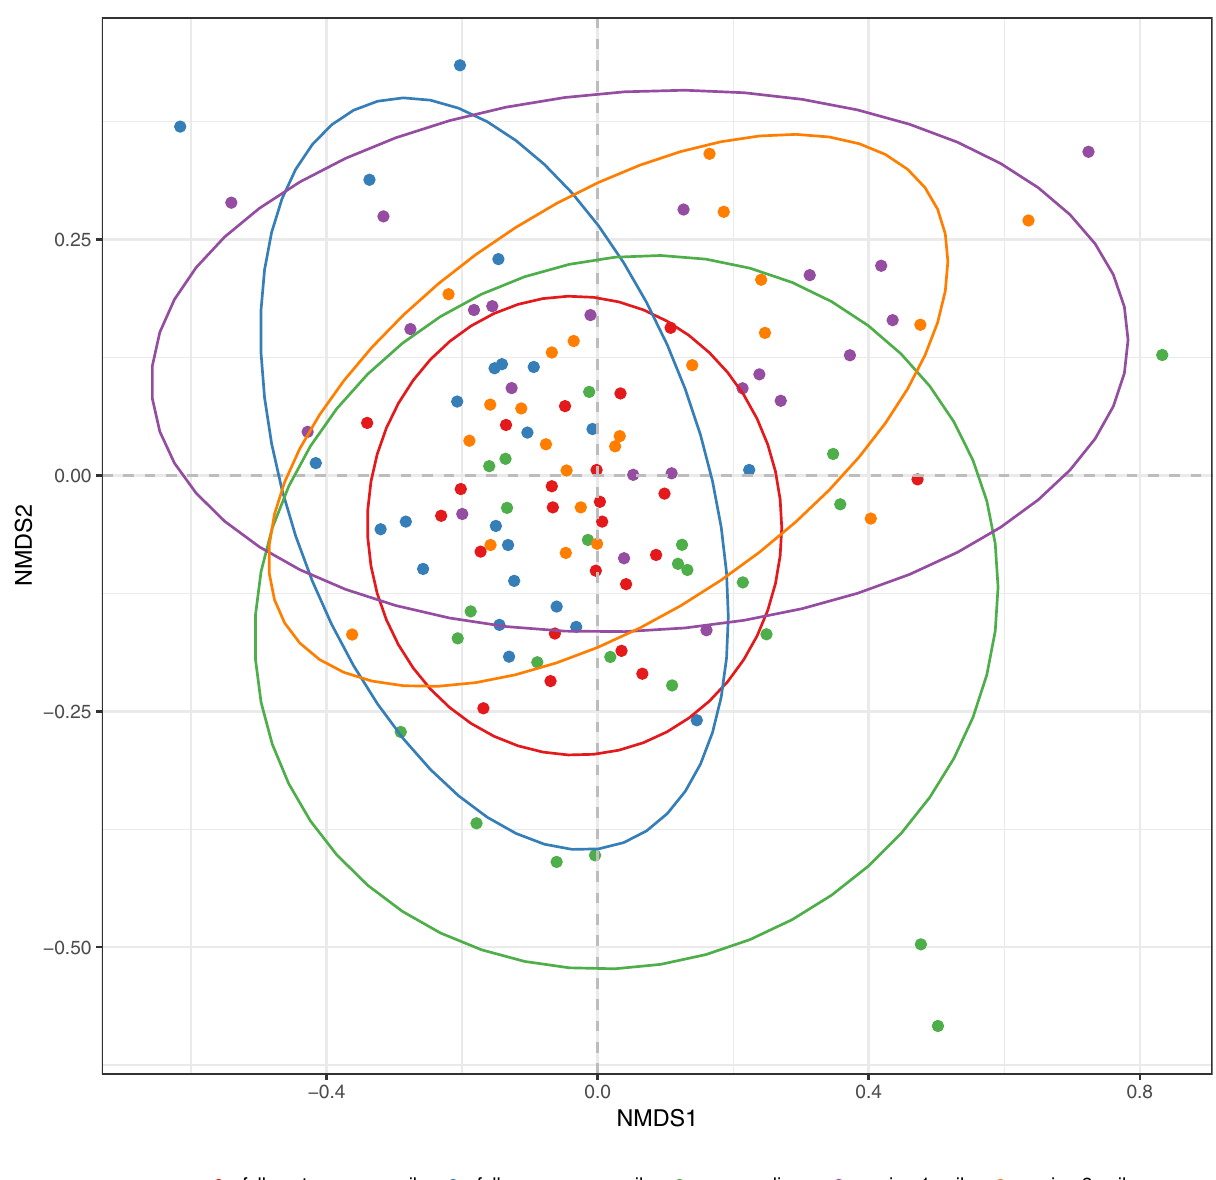
Fig 3. Comparison of community composition between soil and manure line samples. Community composition varied significantly between all samples except between the spring samples. Spring time 1 and spring time 2 soil are combined as spring soil. Clustering is based on nonmetric multidimensional scaling analysis of samples according to Bray-Curtis distances. Manure was excluded from the NMDS plot to show variation of soil samples.